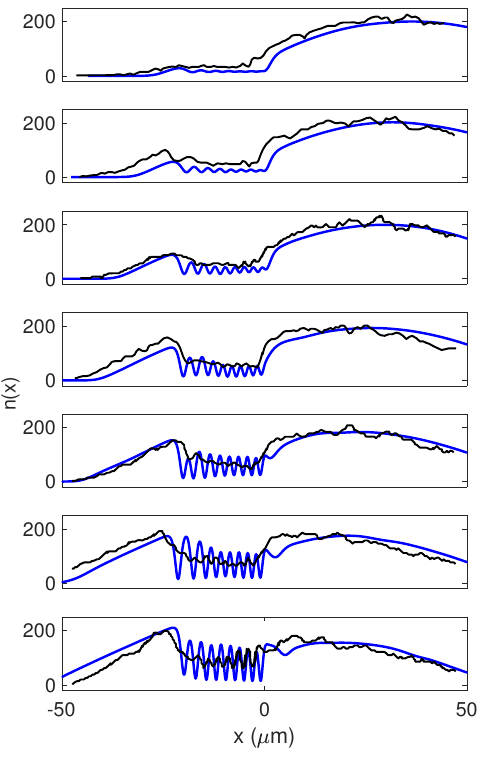
Figure 8: The evolution of a condensate. The density profile is plotted at 20 ms intervals = 0.75 µ , scaled by a common factor to match experiment, and with moving potential step U s viewed in the moving frame where x = 0 defines the step edge. Black: experiment [ 3 ] ; blue: present